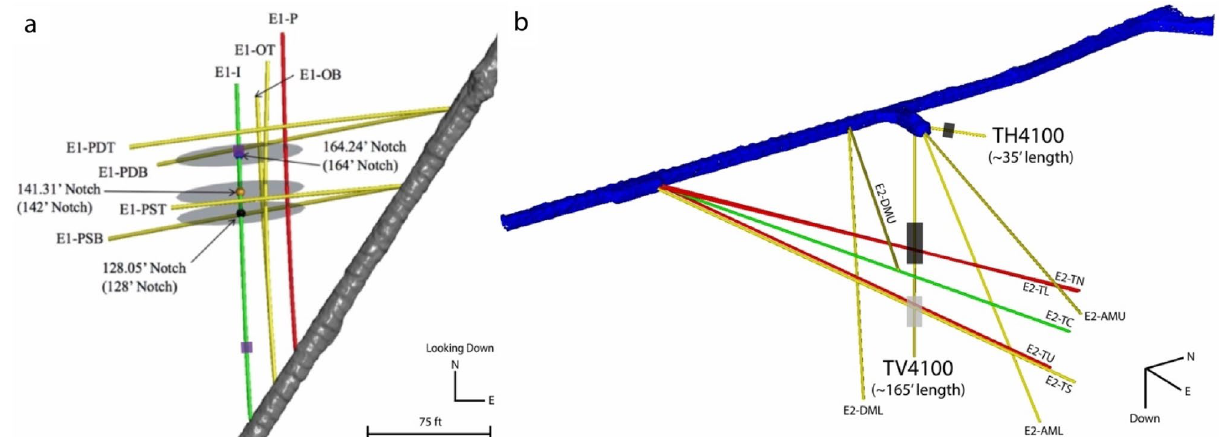
Figure 1. Borehole geometry of testbeds at the SURF. Borehole color indicates utility (green = injection, red = production, yellow = observation). ( a ) 4850-foot level (figure modified from White et al. 2019) 2 . Purple shaded regions indicate locations of schist samples. ( b ) 4100-foot level (figure modified from Kneafsey et al. 2021) 3 . Black shaded regions indicate locations of amphibolite samples; gray shaded regions indicate locations of rhyolite samples.